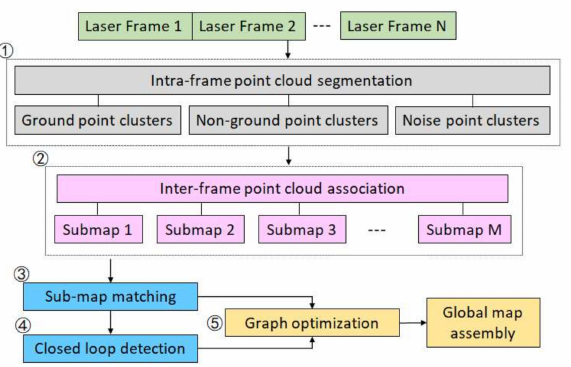
Figure 2. The framework of proposed continuous-time laser frames associating and mapping via multilayer